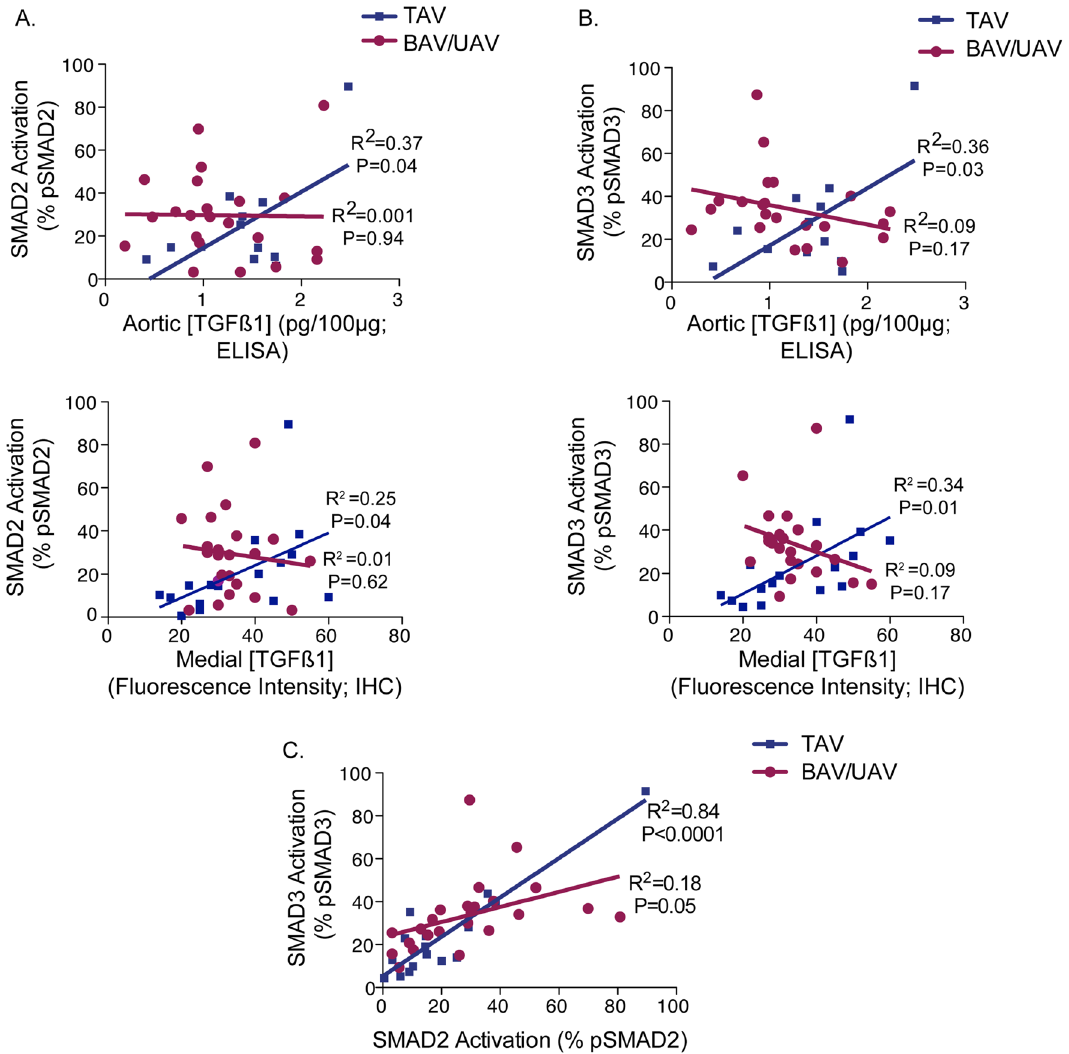
Figure 4. Phosphorylation of SMAD2 and SMAD3 is dependent upon TGFß1 ligand concentration in TAV, but not BAV/UAV aortas. ( A ) Graphs depicting the relationship between TGFß1 ligand concentration (whole aorta: top, medial layer: bottom) and phosphorylated SMAD2 in TAV (blue) and BAV/UAV (pink) aortas. ( B ) Graphs depicting the relationship between TGFß1 ligand concentration (whole aorta: top, medial layer: bottom) and phosphorylated SMAD3 in TAV (blue) and BAV/UAV (pink) aortas. ( C ) Graph depicting the relationship between phosphorylated SMAD2 and phosphorylated SMAD3 in TAV (blue) and BAV/UAV (pink) A subanalysis of the TAV dilated group revealed that 50% (5/10) of the patients had a tubular aortic aneu- rysm, while the remaining 50% (5/10) had an aortic root aneurysm, similar to that seen with connective tissue disorders 19 . Within the TAV dilated individuals there was a trend towards decreased age and increased SMAD3 phosphorylation in those with root aneurysms compared to those with tubular aneurysms ( P = 0.10 and 0.08, respectively; Supplemental Fig. 1). pSMAD2 and pSMAD3 mediate TGFß signaling in TAV, but not in BAV or UAV aortas. We next assessed for relationships between TGFß ligand concentration and the downstream activation of SMAD2/3 in the ascending aorta. In individuals with a TAV, there was a positive correlation between TGFß1 concentration and the level of pSMAD2 (whole aorta: R 2 = 0.37, P = 0.04, medial layer: R 2 = 0.25, P = 0.04; Fig. 4A) and pSMAD3 (whole aorta: R 2 = 0.36, P = 0.03, medial layer: R 2 = 0.34, P = 0.01; Fig. 4B). Interestingly, however, no significant relationships were detected between TGFß1 ligand concentration and either pSMAD2 (whole aorta: R 2 = 0.001, P = 0.94, medial layer: R 2 = 0.01, P = 0.62) or pSMAD3 (whole aorta: R 2 = 0.09, P = 0.17, medial layer: R 2 = 0.09, P = 0.17) in BAV or UAV individuals (Fig. 4A,B). Assessing for relationships between pSMAD2 and pSMAD3 revealed a significant correlation in TAV aortas (R 2 = 0.84, P < 0.0001), whereas a less pronounced relationship in BAV and UAV aortas was observed (R 2 = 0.18, P = 0.05; Fig. 4C).